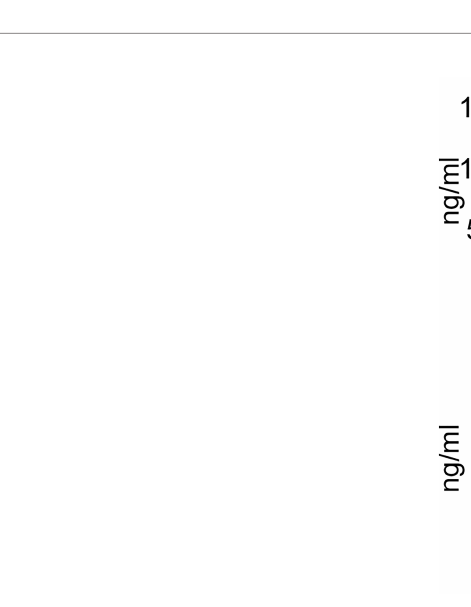
FIGURE 3 | Effect of antibody-mediated depletion of monocytes or neutrophils on adjuvanticity of DDA/TDB. Antigen-speci fi c IFN g and IL-17 secretion of pooled cells from popliteal and inguinal lymph nodes 7 days p.i.; DDA/TDB/H1 s.c. footpad. Depletion with monoclonal antibodies MC-21 (monocytes) or 1A8 (neutrophils); isotype control (rat IgG2 b k ). Mean+SD of 1 of the three representative experiments with fi ve mice/group. Signi fi cance tested by one-way ANOVA and Dunnett ’ s post- test with isotype as control group; *p < 0.05 and **p <